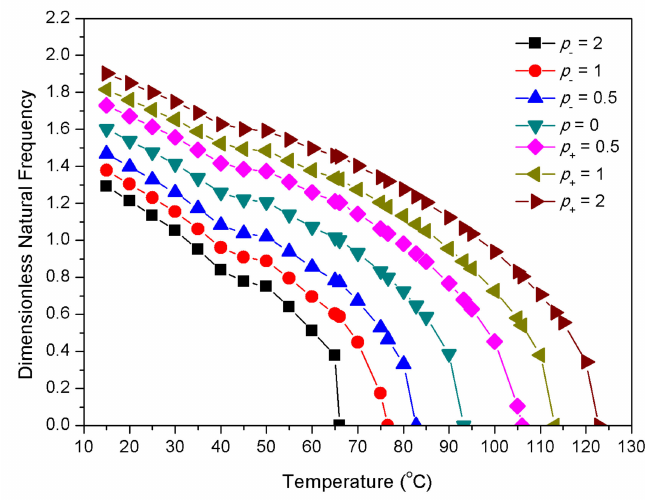
Figure 4. Dimensionless natural frequencies vs. temperature subjected to di ff erent gradient parameter ( p )